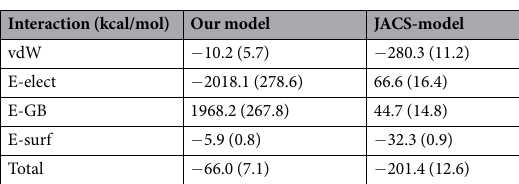
Table 1. Binding energy (in kcal/mol) distribution for the two-fold model (JACS model) of ref. 15 and the one proposed by us in previous work 18 . Each fibril fragment is made of two proto-fibrils with each six layers, see Fig.